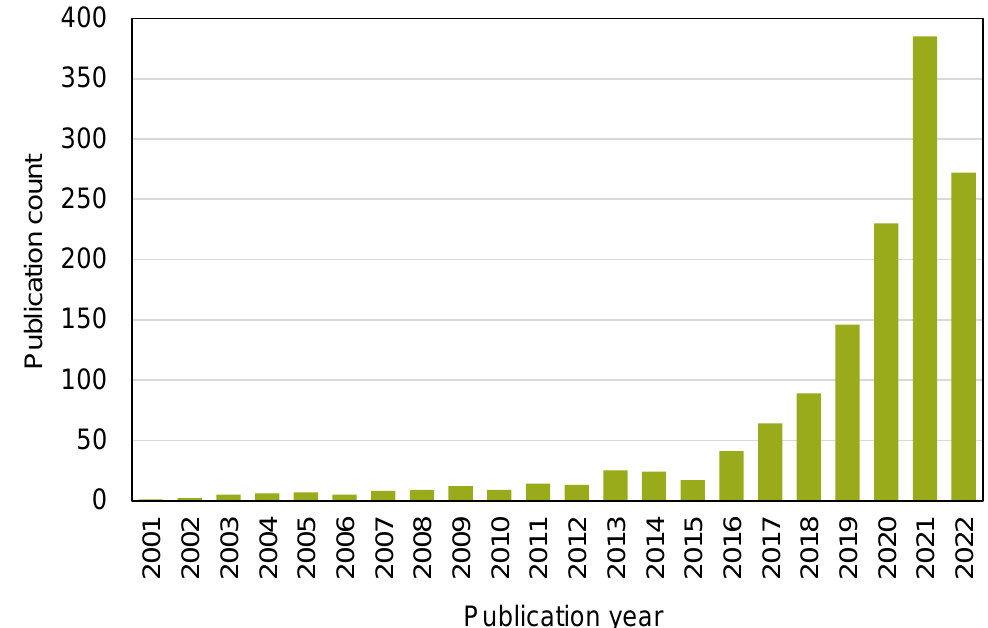
Figure 4. Article types published.